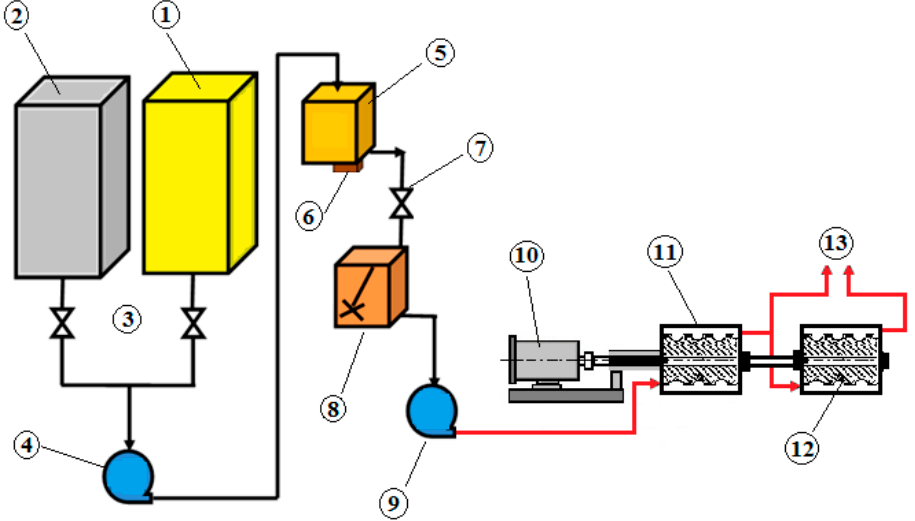
Figure 1. Schematic diagram of continuous Biodiesel production using by shockwave power reactor (SPR). 1: Oil tank, 2: Methoxide tank, 3: Valve, 4: Batching pump, 5: Batching tank, 6: Load-cell, 7: Valve, 8: Homogenizer tank, 9: Feeding pump, 10: Motor, 11: SPR reactor1, 12: SPR reactor2, 13: